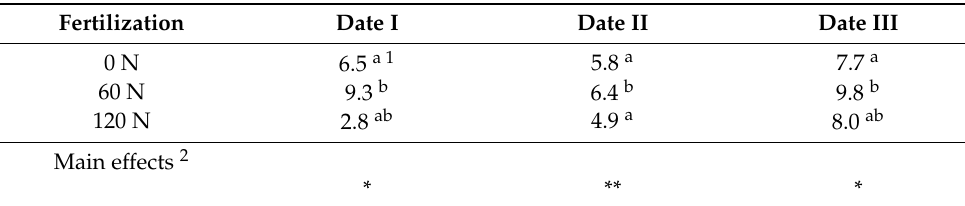
Table 5. Influence of nitrogen fertilization on protease activity in 2011–2013 (mg tyrosine 24 h − 1 kg − 1 DW